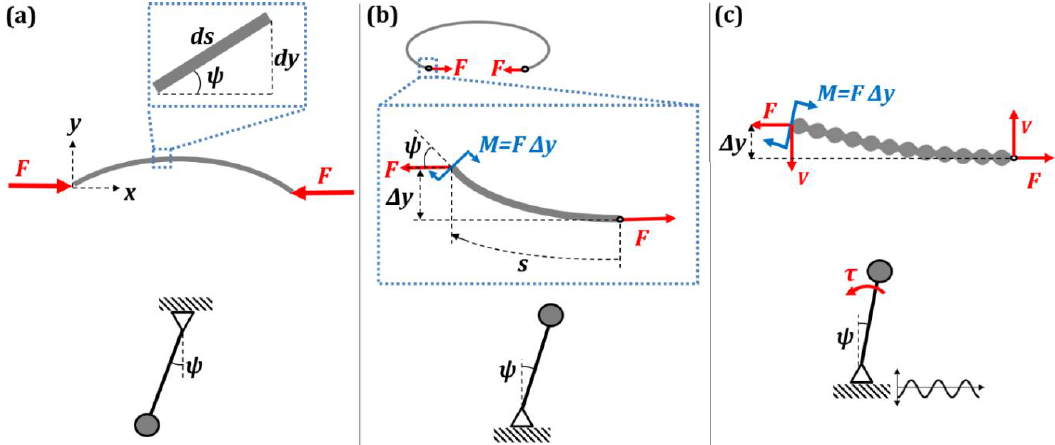
Figure 3. The deflection of a beam due to ( a ) compressive load F (corresponding to the stable equilibrium of a regular pendulum), and ( b ) tensile load F (corresponding to the unstable equilibrium of an inverted pendulum). ( c ) The waviness of the beam would stabilize the equilibrium similarly to the vibrations stabilizing an inverted pendulum (reproduced with permission from [11]).